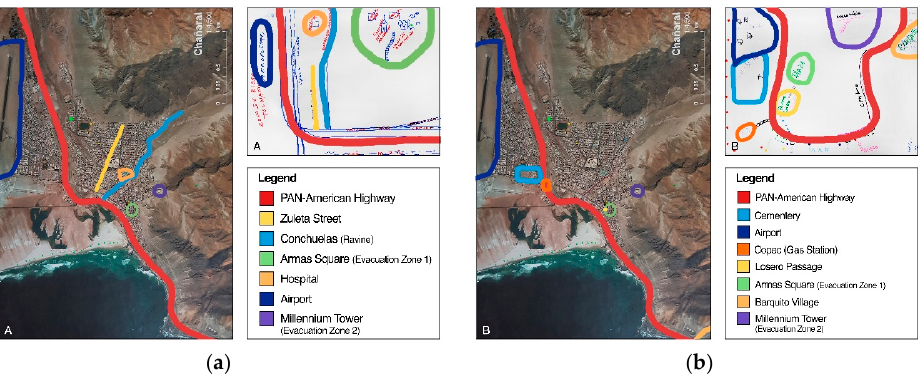
Figure 9. The map of Chañaral (reality) vs. Sketch map (perception): ( a ) Group 1, ( b ) Group 2.